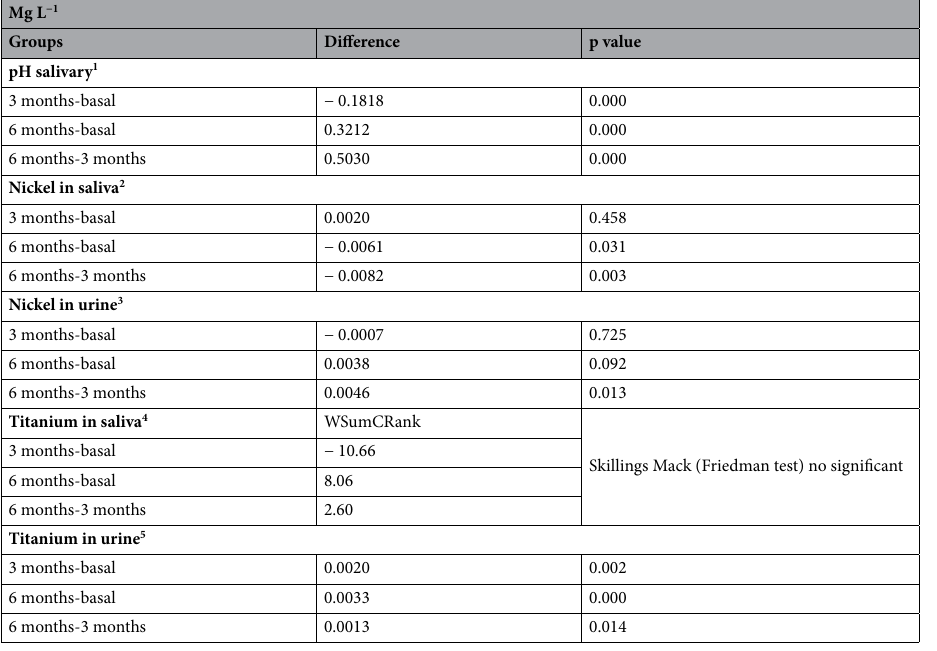
Table 2. Multiple ANOVA by groups between the average concentrations of nickel and titanium in saliva, urine and pH salivary. Delta-method Pairwise comparisons of adjusted predictions. 1 ANOVA p = 0.0000,